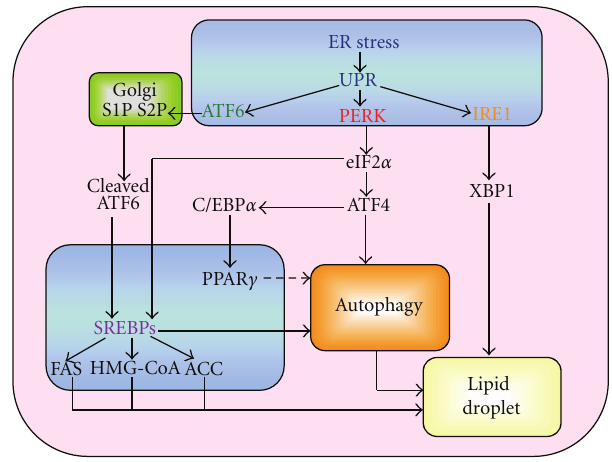
Figure 1: Potential link between ER stress signaling pathways and lipid droplet formation in